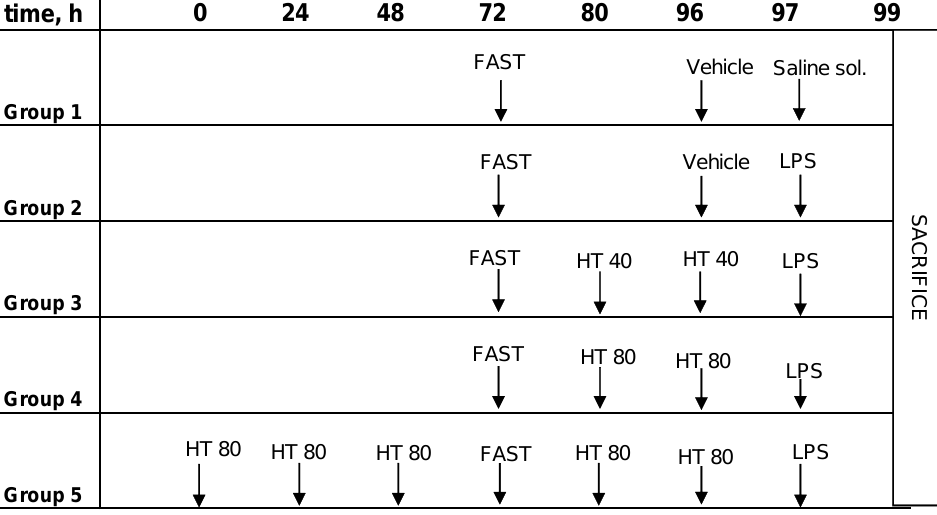
Scheme 1. Diagram of the protocol design for the study of HT anti-inflammatory and